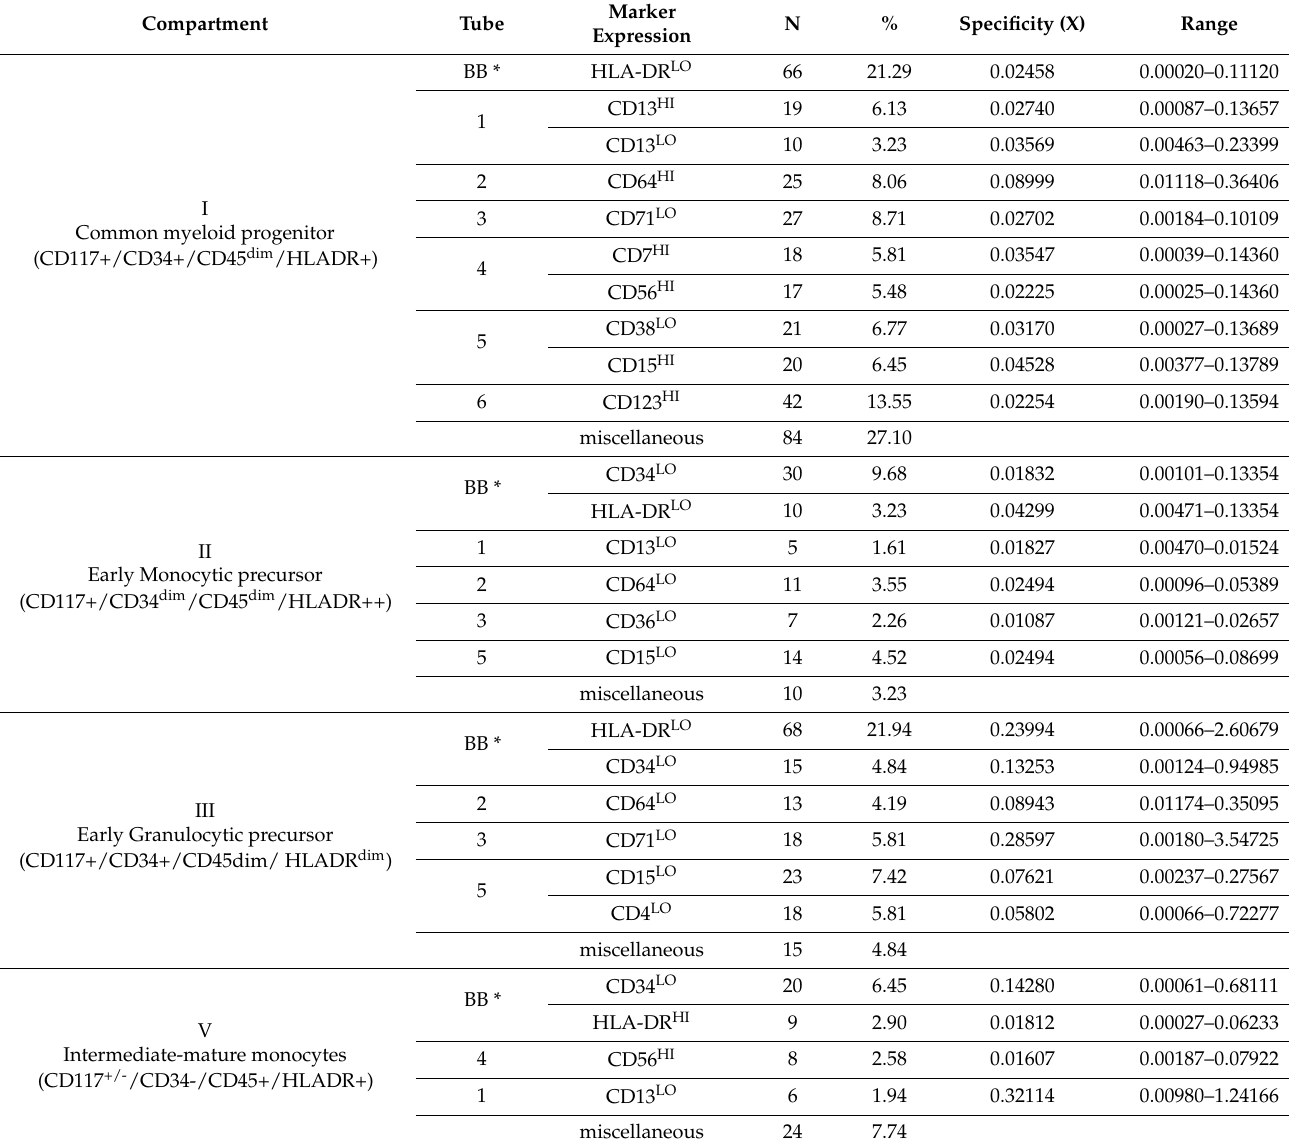
Table 2. Distribution of LAIPs in the different